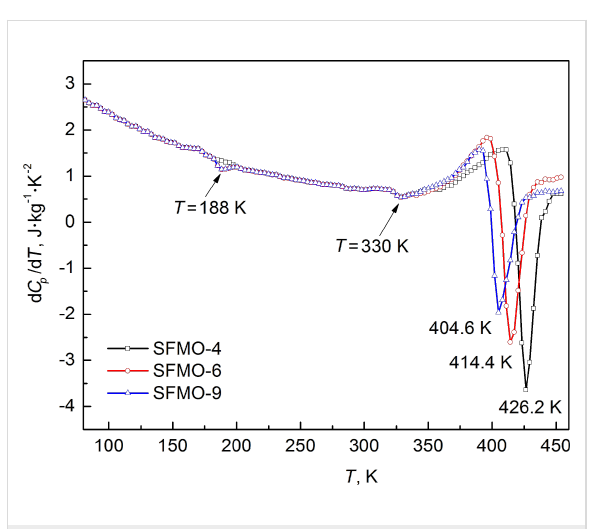
Figure 4: The temperature dependence of the heat capacity deriva- tive of nanopowders, SFMO-4, SFMO-6 and SFMO-9.